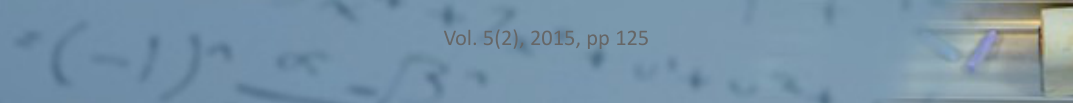
Figure 1. Image of the Google+ community that was